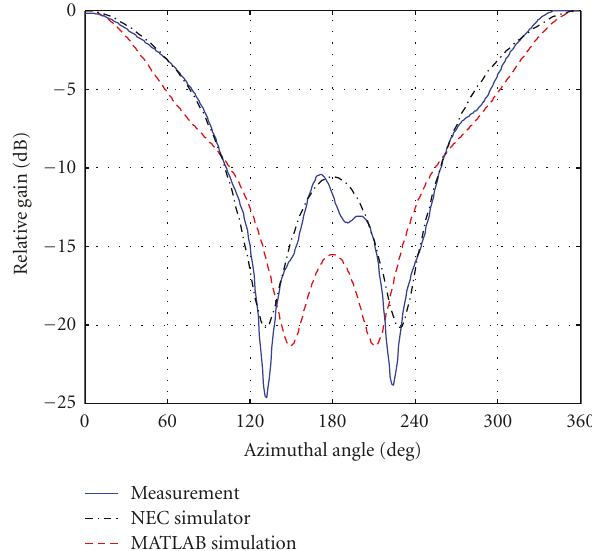
Figure 3: Comparison of the directional beam patterns of measure- ment and simulation using MATLAB and NEC simulator.